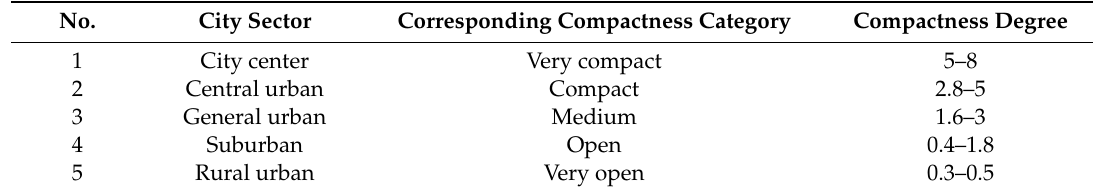
Table 1. Categories and ranges of the compactness degree scale